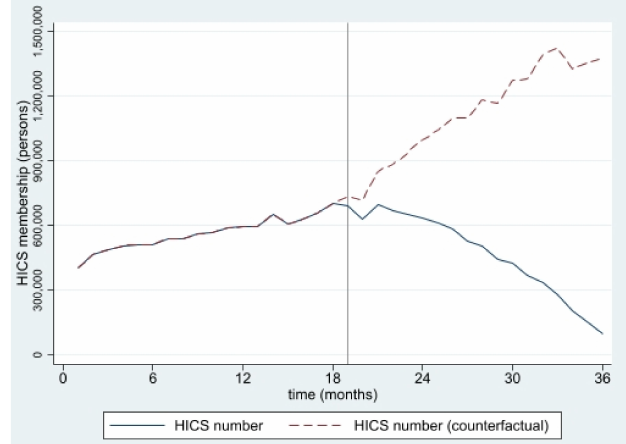
Figure 4. HICS membership, Greater Bangkok (2016–2018).